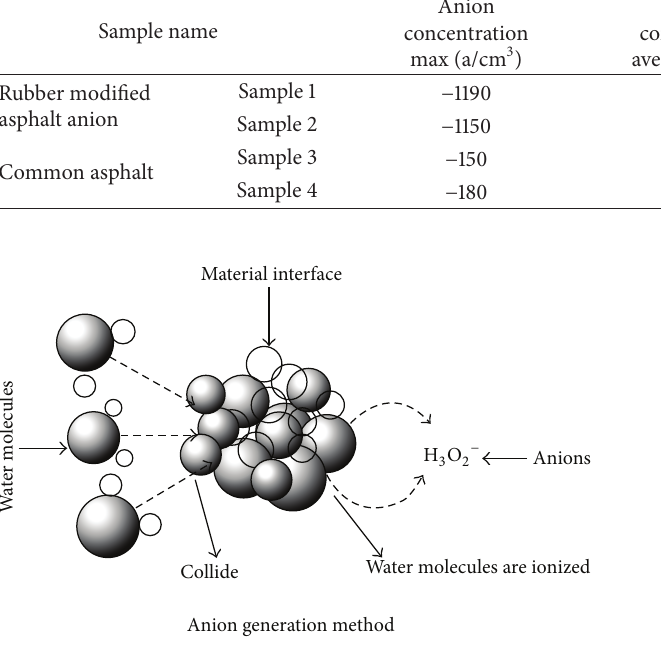
Figure 5: A negative ion generation method.